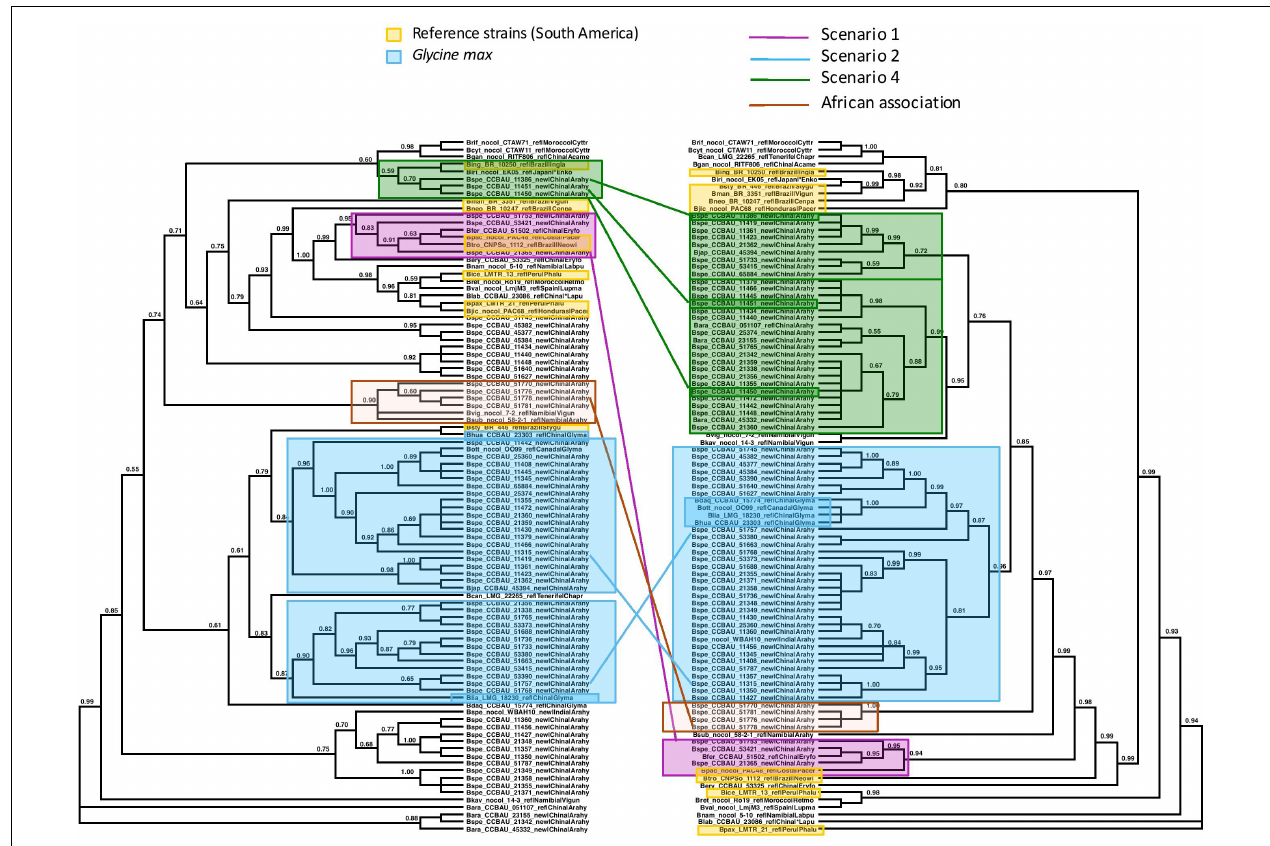
FIGURE 3 | Maximum Likelihood trees of the concatenated sequences of 16S region and the housekeeping genes r ecA, dnaK, glnII on the left, labeled “Species Tree”, and on the right, of the symbiotic nifH gene. Nodes with lower bootstrap support than 60% were collapsed into polytomies. Bootstrap support is coded for each node. The two trees differ significantly in topology (Approximate Unbiased (AU) test p < 0.05). We identified clades or clusters of strains of bacteria on the two trees that illustrated the different scenarios outlined in Figures 1 , 2 . Clades or clusters are identified with a color-coding by their host plant, and different colored lines to illustrate the different scenarios join individual strains or clades on the two trees. When more than one member of a clade or cluster followed the same evolutionary scenario we chose a single one to illustrate it. The scenarios shown do not represent all events that can be traced from this phylogeny, but are representative of the events that it elucidates. We also mark a clade of bacteria isolated from peanut in China that cluster with Namibian bacterial isolates on the species tree but form an isolated clade that includes no reference strains on the nifH